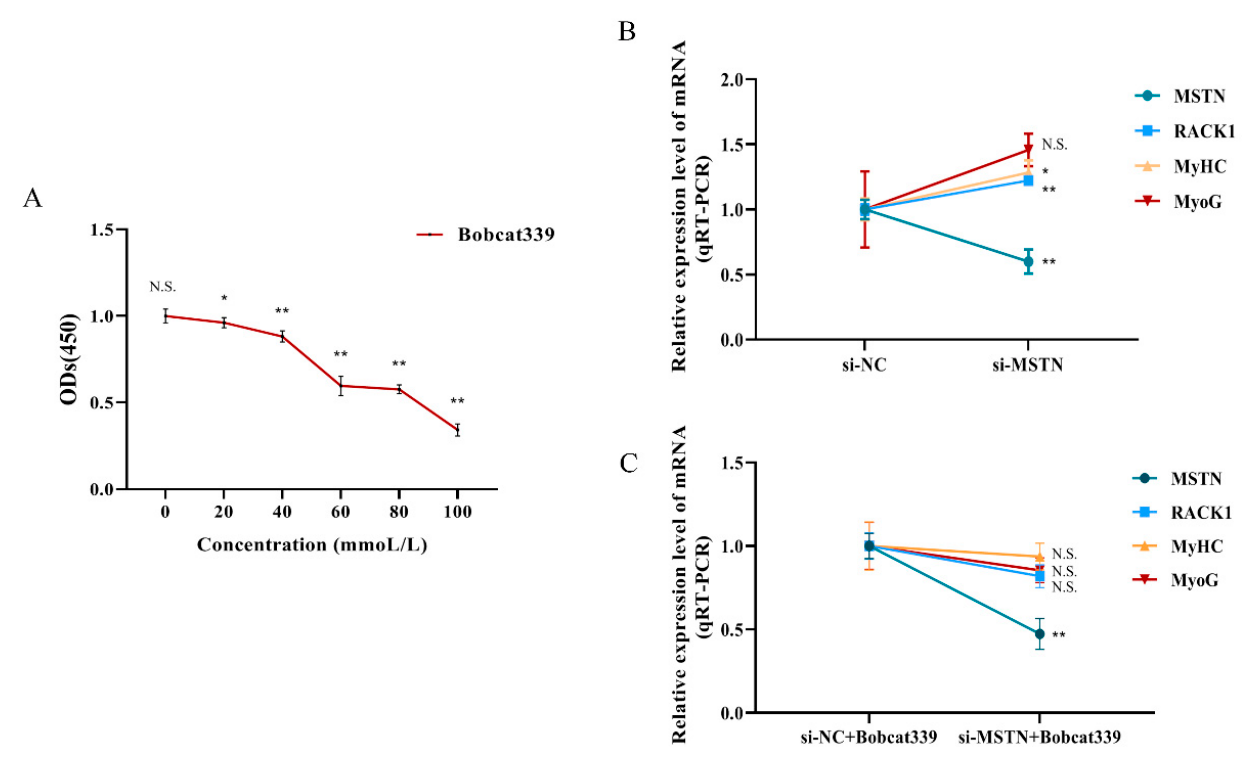
Figure 4. Inhibition of DNA demethylation pathways and muscle differentiation. ( A ) CCK-8 experi- ment to exclude Bobcat339. ( B , C ) The effects of Bobcat339 on RACK1, MyHC, and MyoG (( B ) is the Bobcat339 control group, and ( C ) is the Bobcat339 experimental group). Differences between groups were statistically analyzed using Student’s t -test. p < 0.05 was considered statistically significant (* p < 0.05 and ** p < 0.01). And N.S., not significant ( p > 0.05).